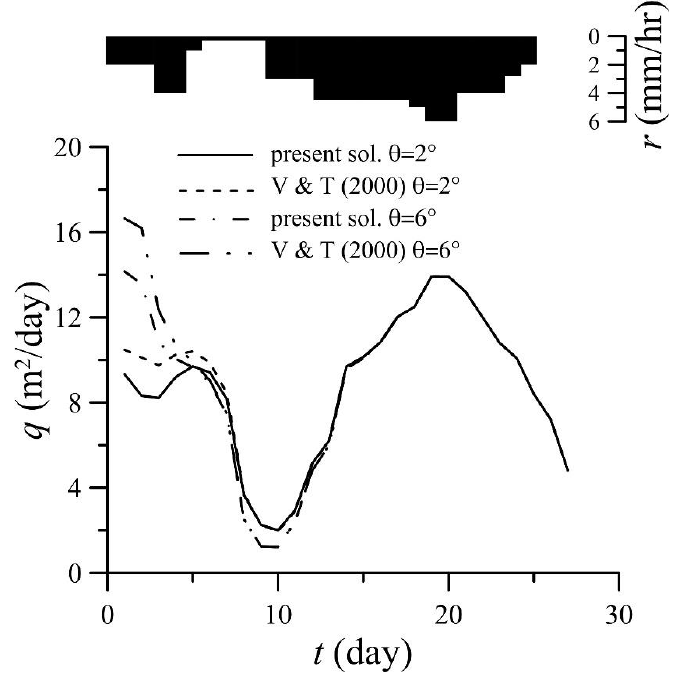
Figure 9. Variation in the outflow corresponding to varying recharge rates, as illustrated in the study of Verhoest and Troch [7]. of Verhoest and Troch